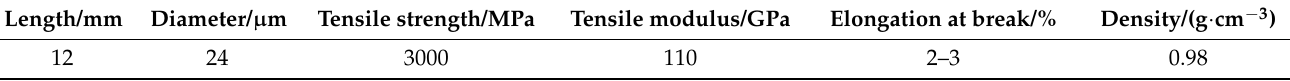
Table 2. Basic physical properties of PE fibers.